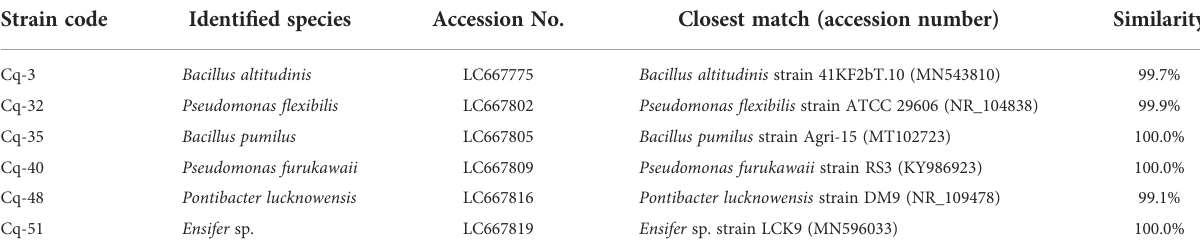
TABLE 6 Identi fi cation of Chenopodium quinoa- associated bacterial strains based on 16S rRNA gene sequence analysis. Strain